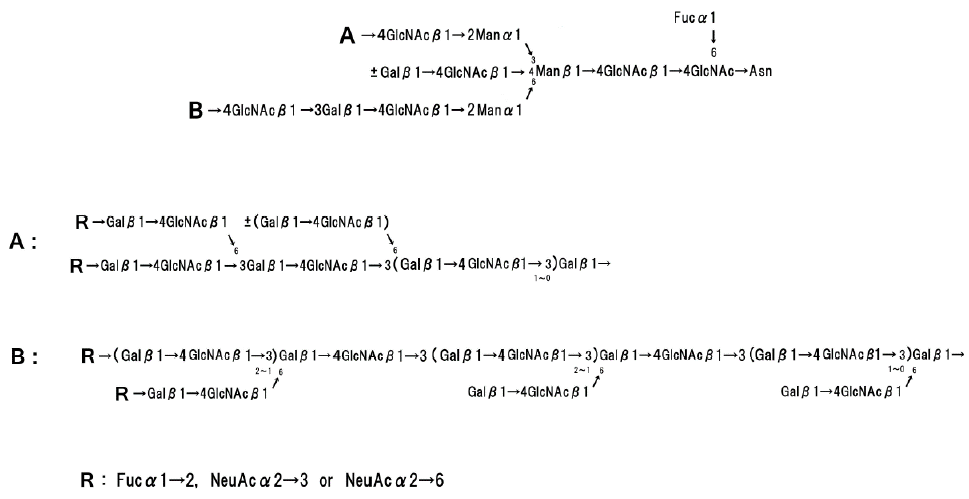
Figure 4. N-linked oligosaccharides of human band 3.